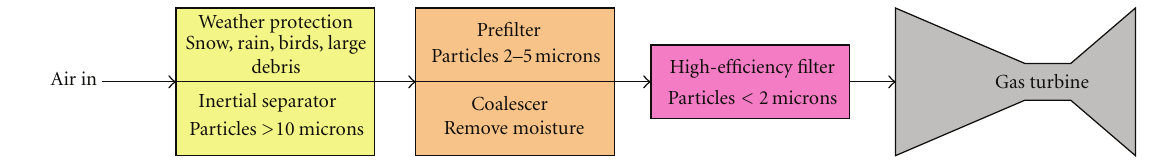
Figure 10: Multistage filtration